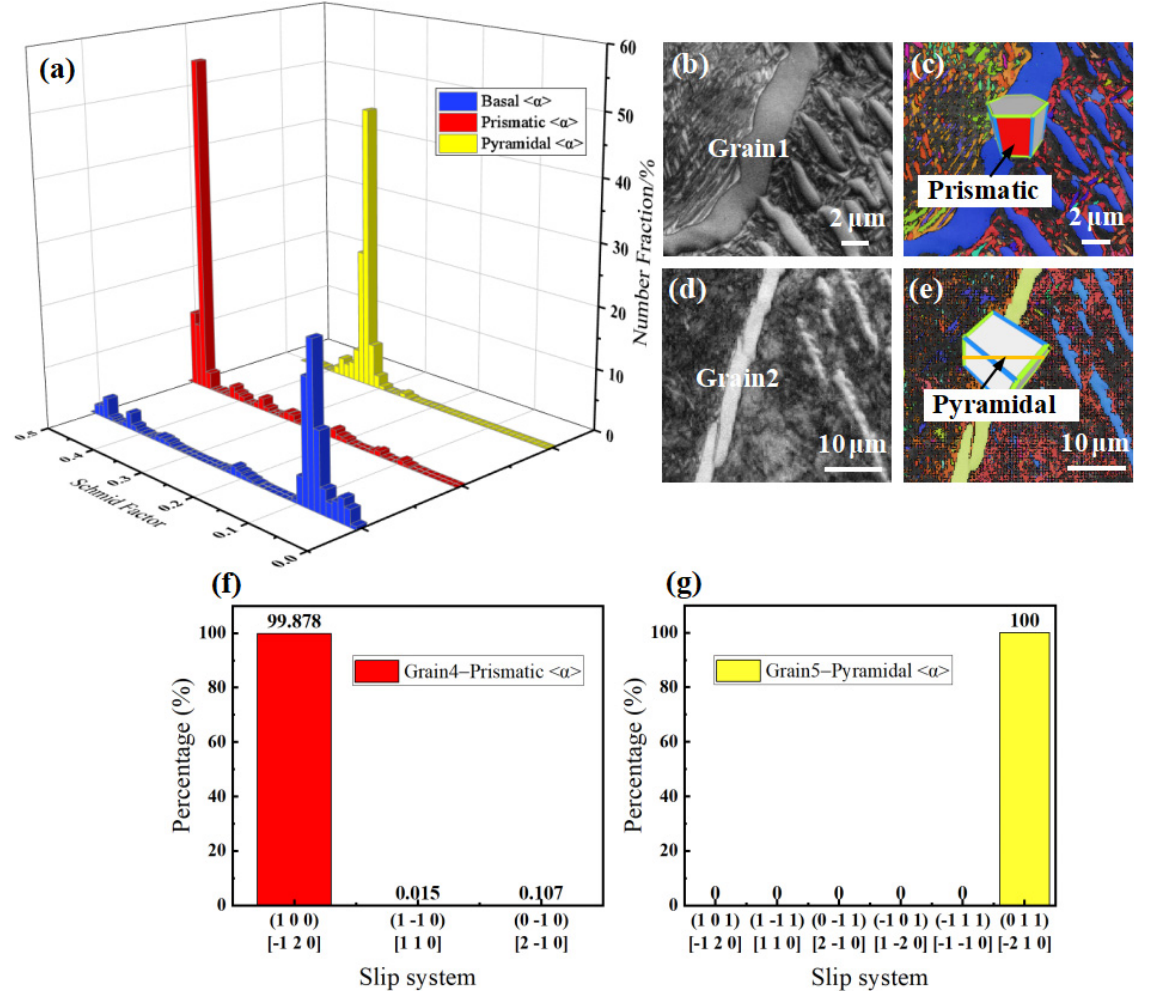
Figure 13. ( a ) SF histogram of α phase with basal < α >, prismatic < α >, and pyramidal < α > slip systems for specimens with a lamellar microstructure after stretching in situ; ( b , c ) Prismatic slip activation of grain 4 in the α L phase; ( d , e ) Pyramidal slip activation of grain 5 in the α L phase; ( f ) The (100)[ 1 20] of prismatic slip system activation for grain 4; ( g ) The (011)[ 2 10] of pyramidal slip system activation for grain 5.